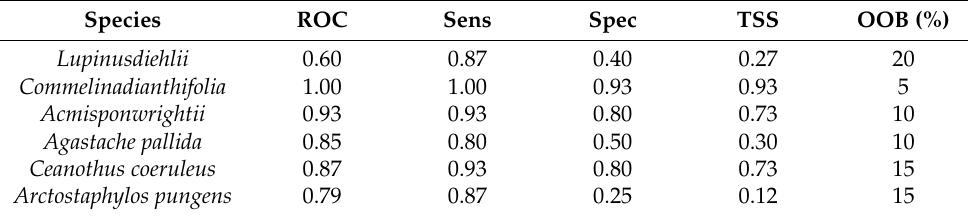
Table 5. Quality index of the Random Forest models of species presence with soil variables. Species ROC